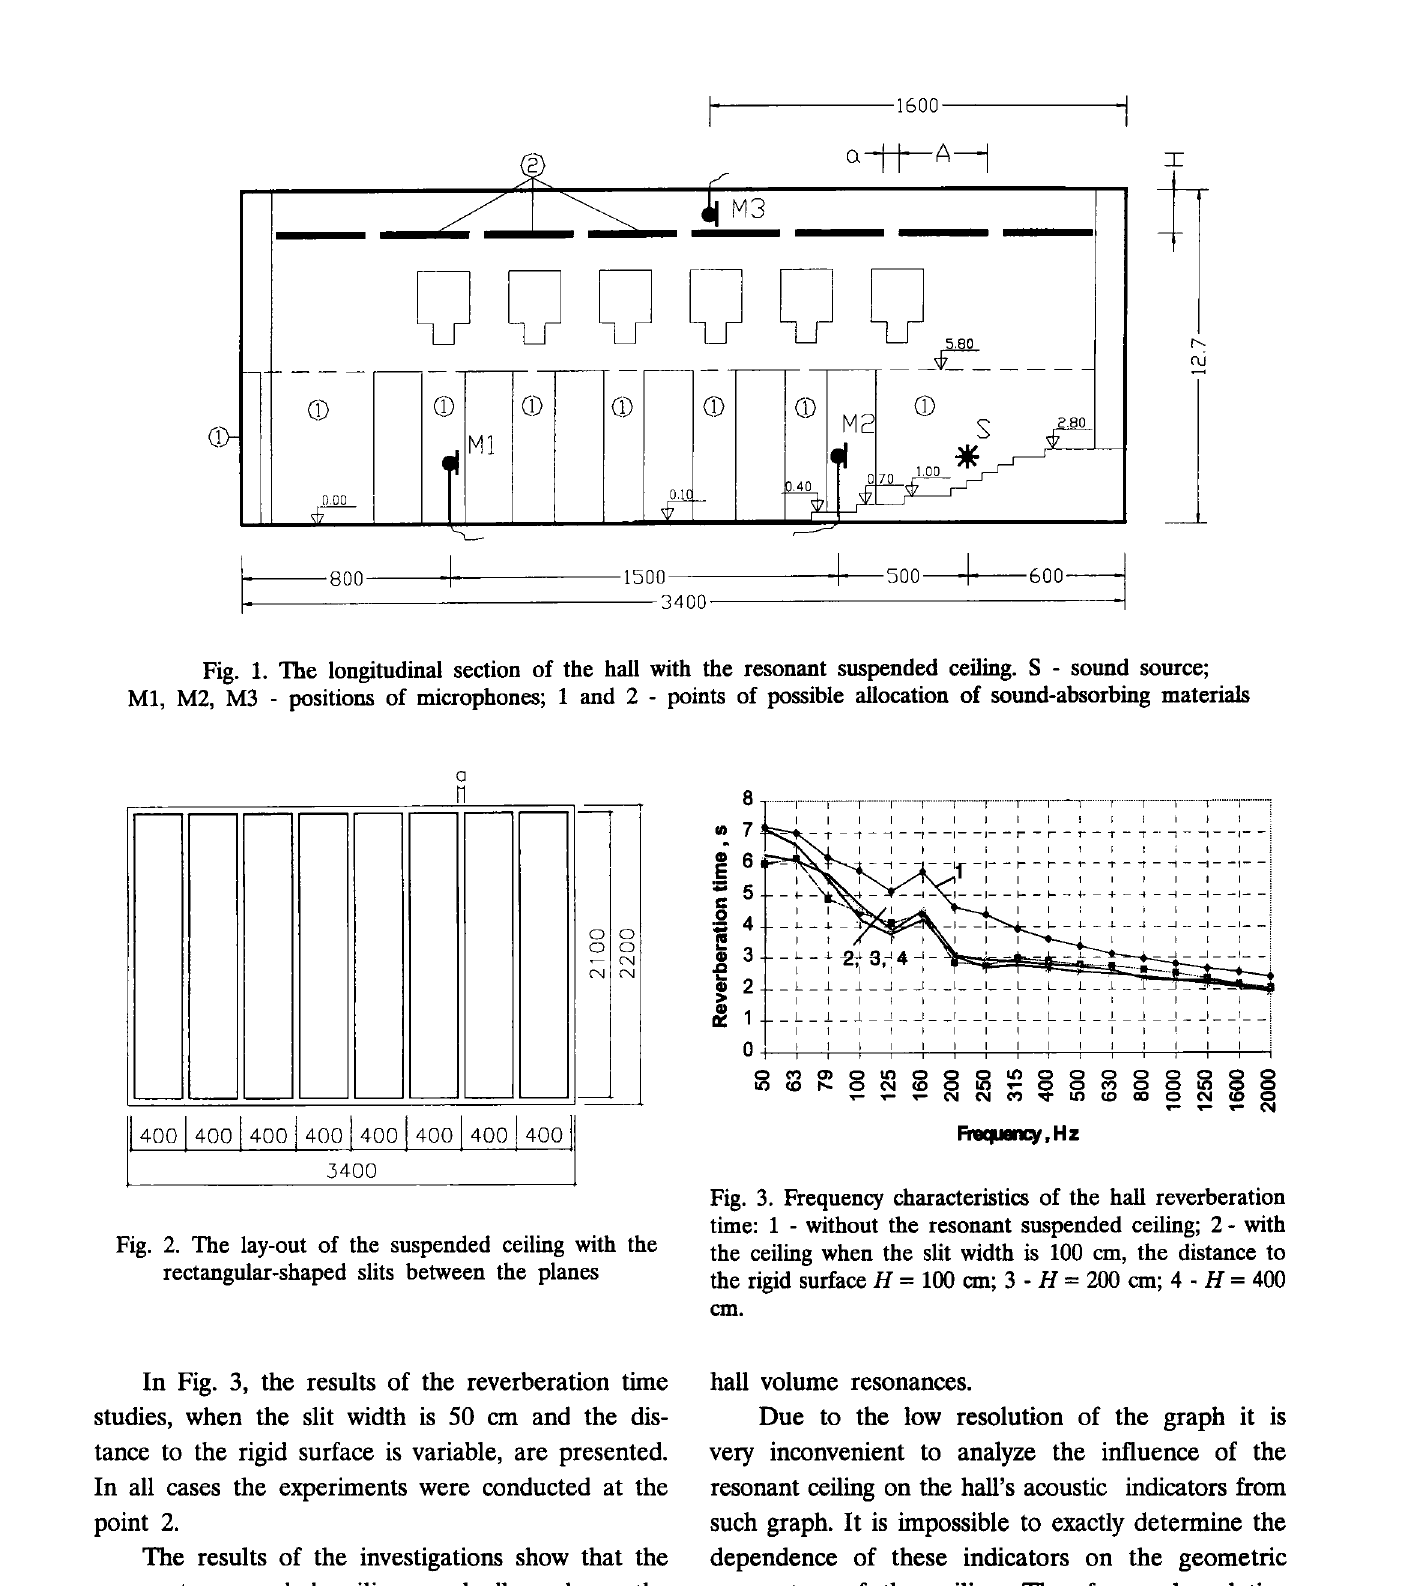
Fig. 3. Frequency characteristics of the hall reverberation time: 1 - without the resonant suspended ceiling; 2 - with the ceiling when the slit width is 100 em, the distance to the rigid surface H = 100 em; 3 - H = 200 em; 4 - H = 400